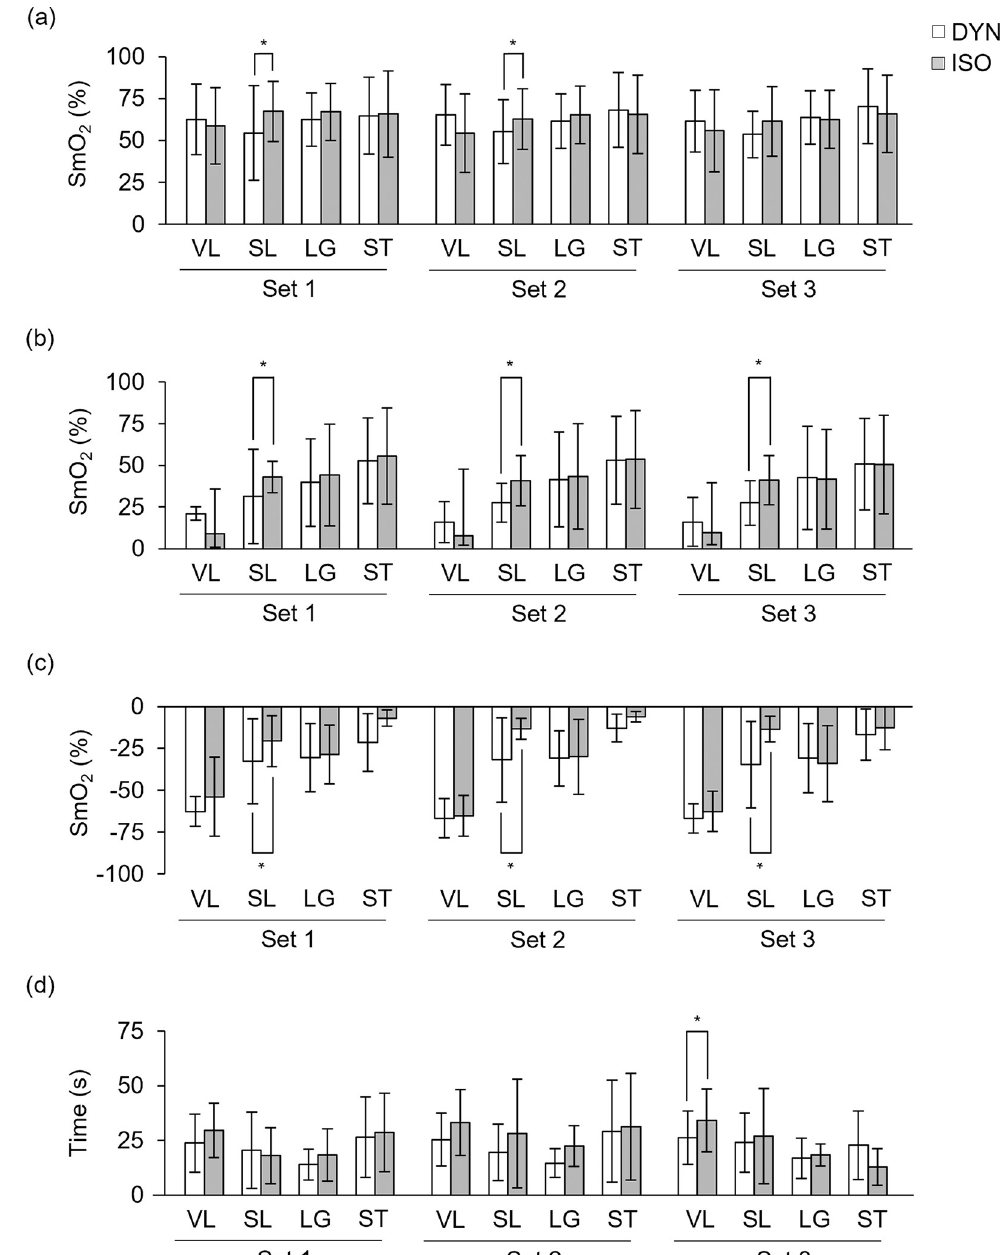
Fig 3. SmO 2 avg (a), SmO 2 min (b), Δ SmO 2 deoxy (c) and t SmO 2 50%reoxy (d) results. DYN, dynamic contraction protocol; ISO, isometric contraction protocol; VL, vastus lateralis ; SL, soleus ; LG, longissimus ; ST, semitendinosus . � p �